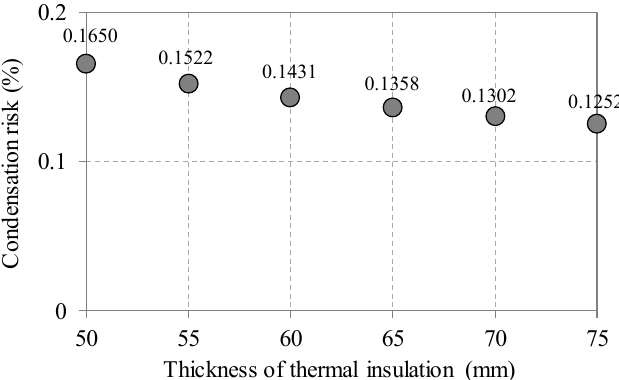
Figure 12. Condensation risk with different thicknesses of the insulation of the external wall (50–75 mm).